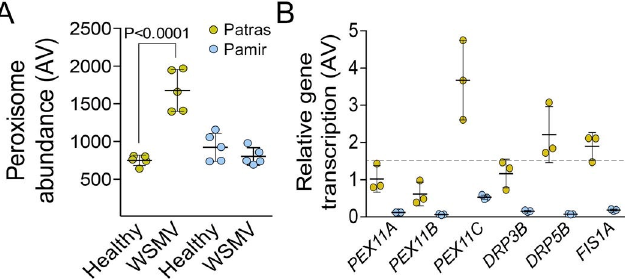
Figure 3. Impact of WSMV infection of peroxisome proliferation. ( A ), Peroxisome abundance in leaf of healthy and WSMV-infected plants. ( B ), Relative transcription level of genes responsible for peroxisome proliferation in leaf of healthy and WSMV-infected plants. The values are expressed relatively to the transcription level of the same gene in the control. The horizontal broken line represents 1.5 fold increase relatively to the control. RLI (RNase L inhibitor-like protein) gene was used as housekeeping control. Five biological replicates (individual plants) were analyzed in ( A ) and three individual plants were analyzed in ( B ). p values were calculated using non-paired t -test.